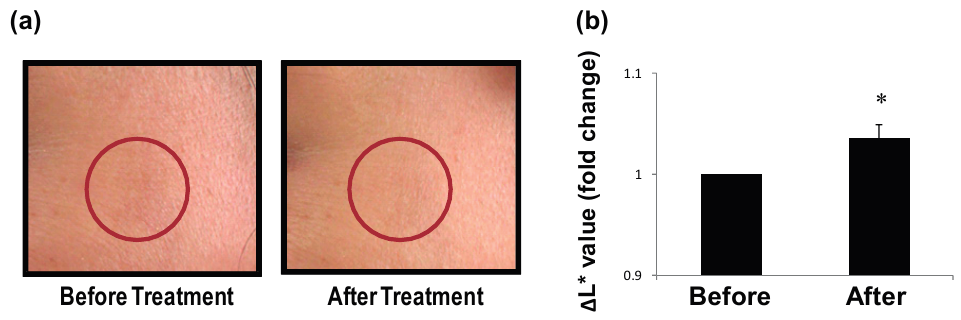
Figure 4. Skin pigmentation is reduced upon applying 5% liquid crystal gel (LCG) cream twice daily for one month. ( a ) Photographs of the same section of a subject’s face before ( left panel ) and after ( right panel ) treatment, with the red circle denoting a particularly hyper-pigmented area of interest; ( b ) Reduction in pigmentation of age spots before and after treatment as measured by L * values denoting brightness ( n = 3, p <